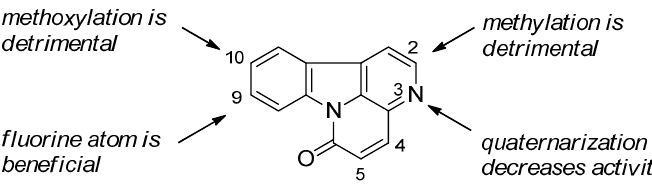
Figure 2. Structure-activity relationships for antifungal activity.